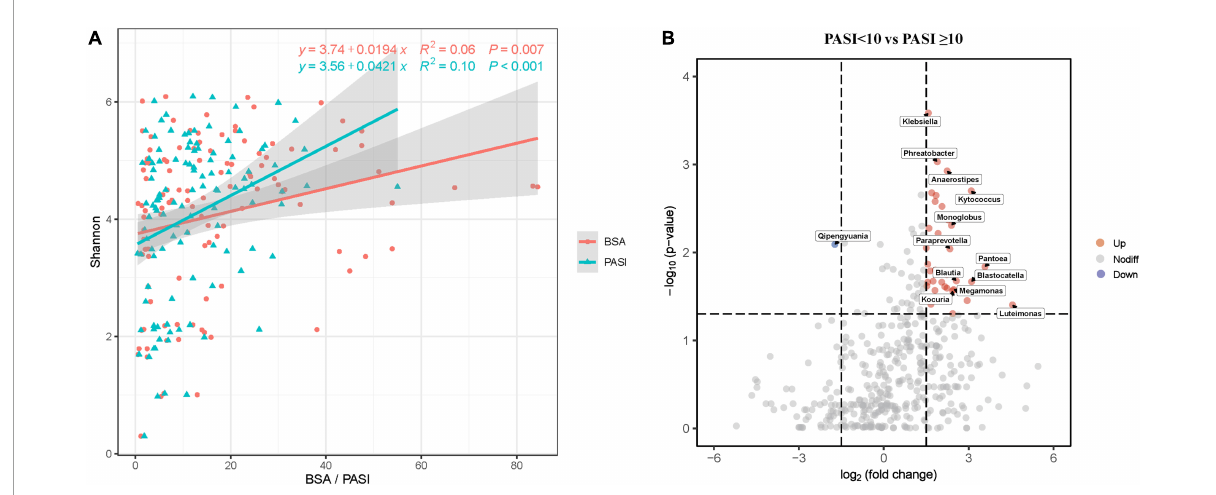
FIGURE3 Skin microbial dysbiosis is associated with psoriasis PASI and BSA scores. (A) Scatter plot showing positive correlations between the Shannon index and PASI and BSA scores. Only statistically significant correlations are shown. Linear regression lines are shown in each scatter plot in red (BSA) and green (PASI), and shaded regions represent 95% CIs. (B) The volcano plots show the relative fold changes and whether they were significant. Assessed by the Wilcoxon rank-sum test, the p -values for each genus (or higher-level OTU) represent the statistical significance of abundance changes in the PASI ≥ 10 group compared with the PASI < 10 group. Red (increased) and green (decreased) bubbles indicate significant differential distribution ( p < 0.05). PASI, psoriasis area and severity index; BSA, body surface